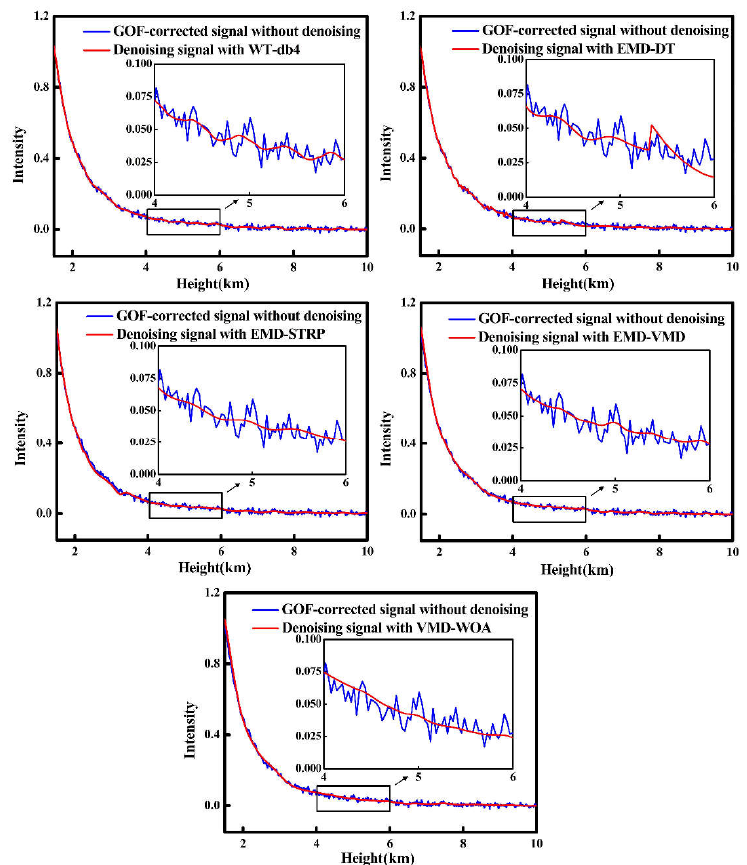
Figure 8. Comparison of denoising results from the proposed VMD-WOA and the other methods. GOF is geometric overlap factor.